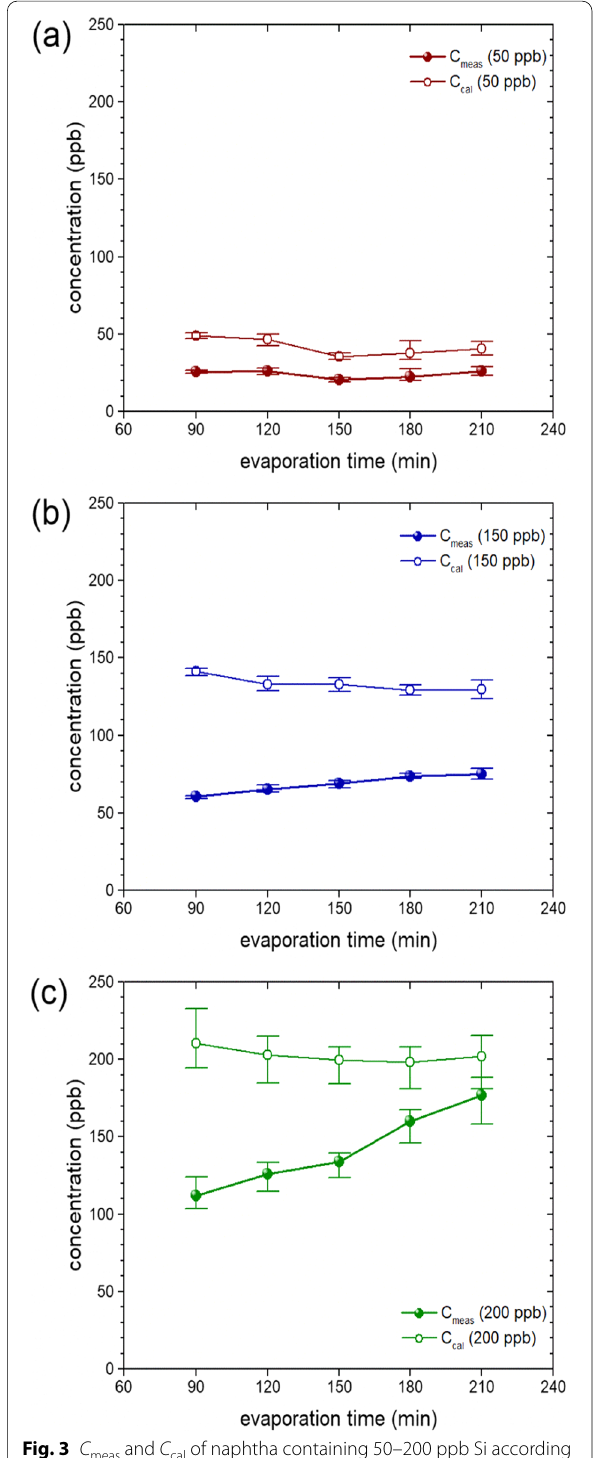
Fig. 3 C meas and C cal of naphtha containing 50–200 ppb Si according to the evaporation time. Error bars encompass the spread between the minimum and maximum measurement values